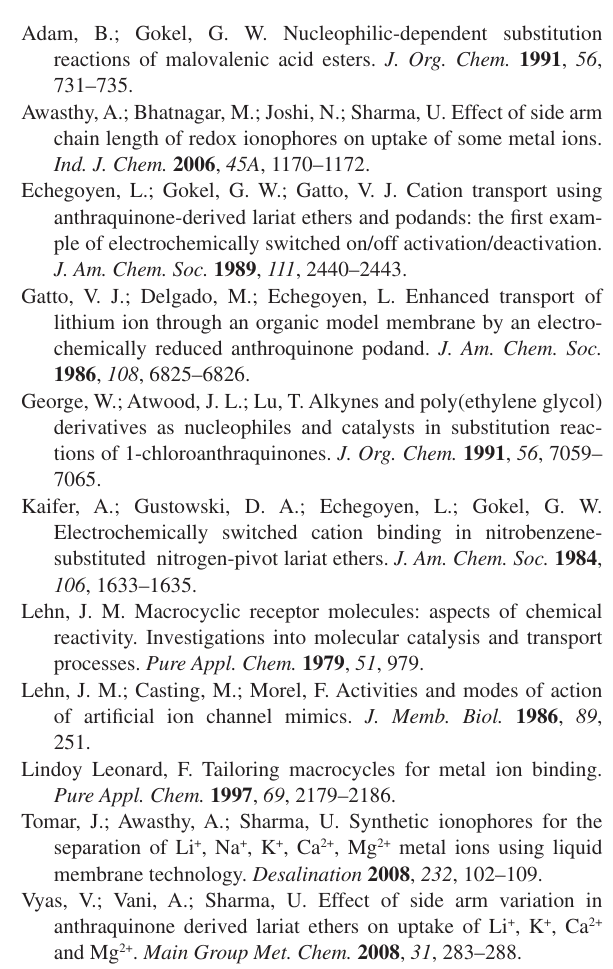
Concentration of metal ion: 1 × 10 -3 m . Concentration of ionophore: 1 × 10 -2 m